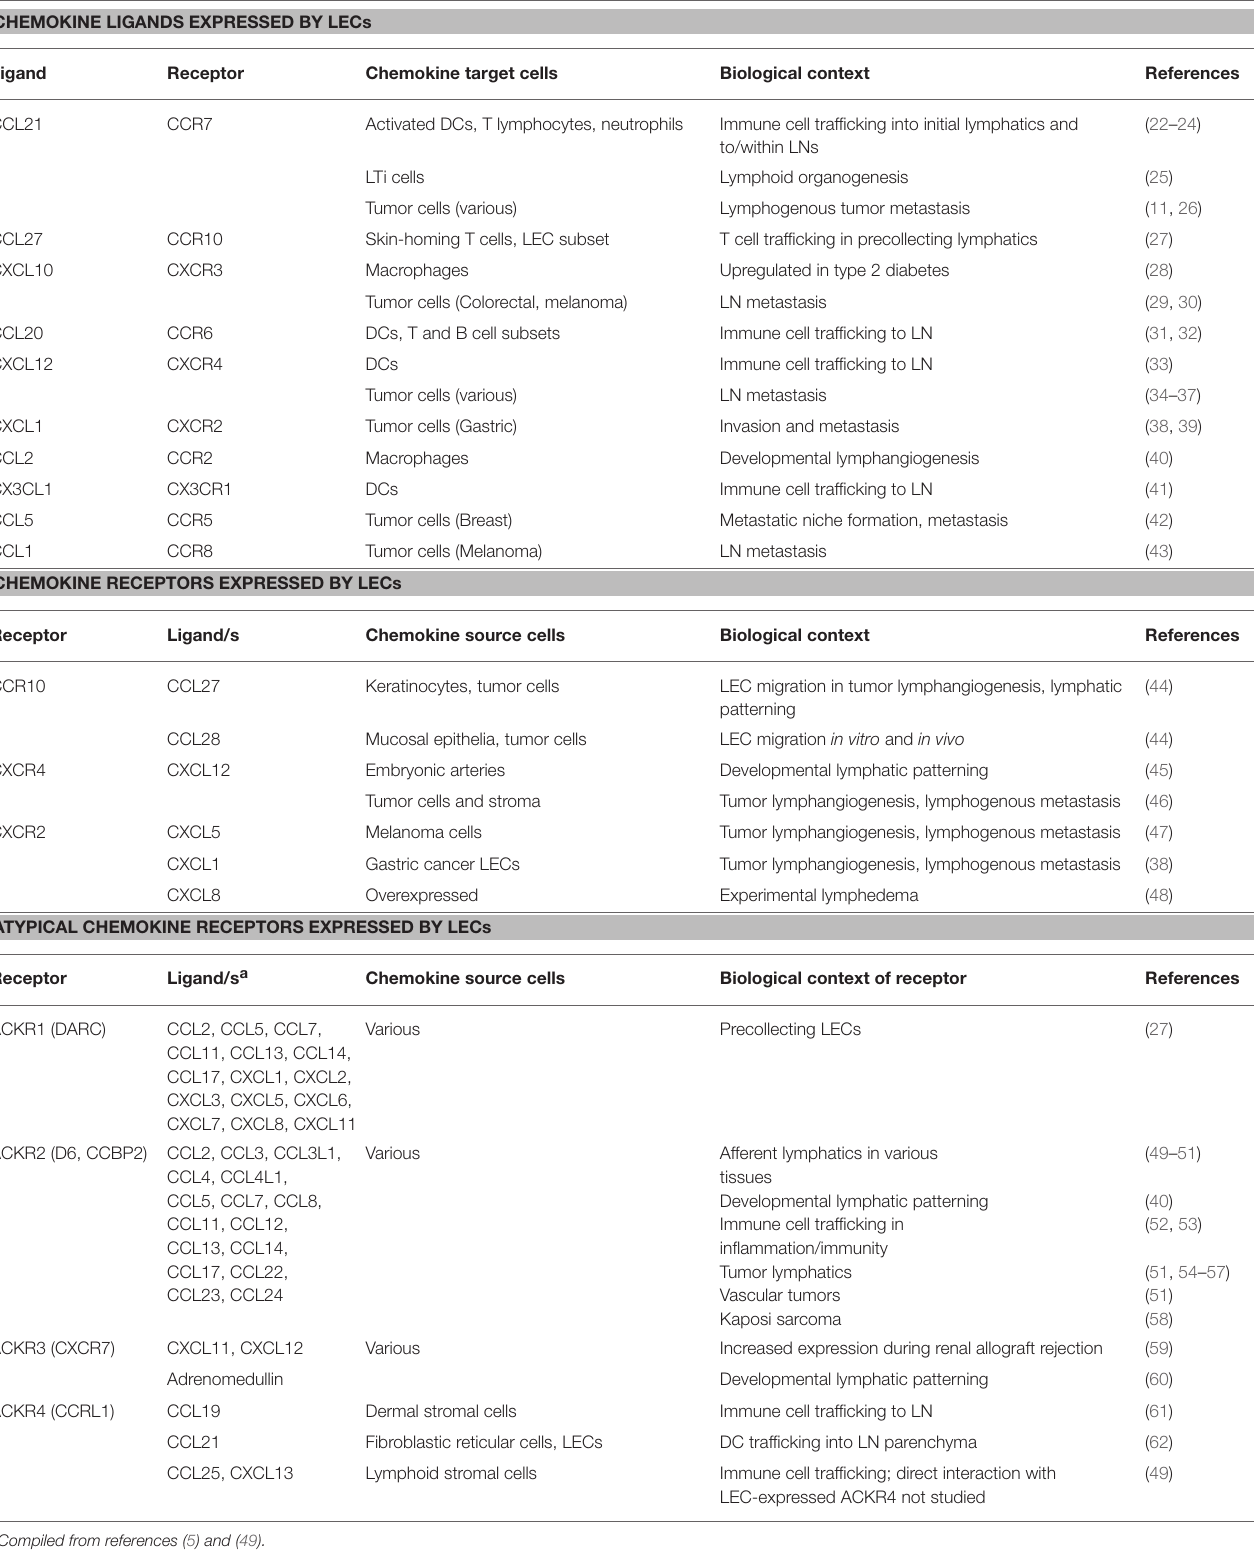
TABLE 1 | Chemokine-mediated cellular interactions with LECs. CHEMOKINE LIGANDS EXPRESSED BY